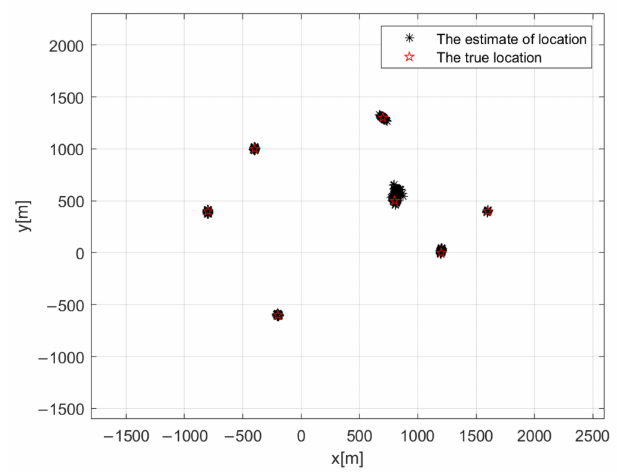
Figure 5. Scatter plots of the R-QSS-SDF-DPD algorithm for NAs.